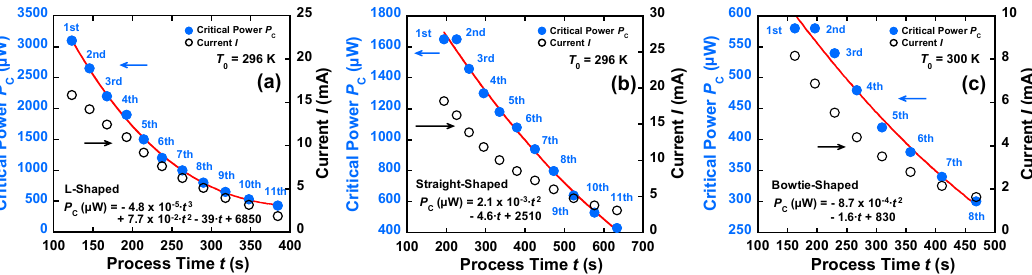
Figure 6. Time evolution of the P C – I characteristics of the ( a ) L-shaped, ( b ) straight-shaped, and ( c ) bowtie-shaped nanowires as a function of the FCE process time. The red lines indicate the fitting result of P C ( µ W): ( a ) − 4.8 × 10 − 5 · t 3 + 7.7 × 10 − 2 · t 2 − 39 · t + 6850 ( R = 0.999), ( b ) 2.1 × 10 − 3 · t 2 − 4.6 · t + 2510 ( R = 0.997), and ( c ) − 8.7 × 10 − 4 · t 2 − 1.6 · t + 830 ( R = 0.991).